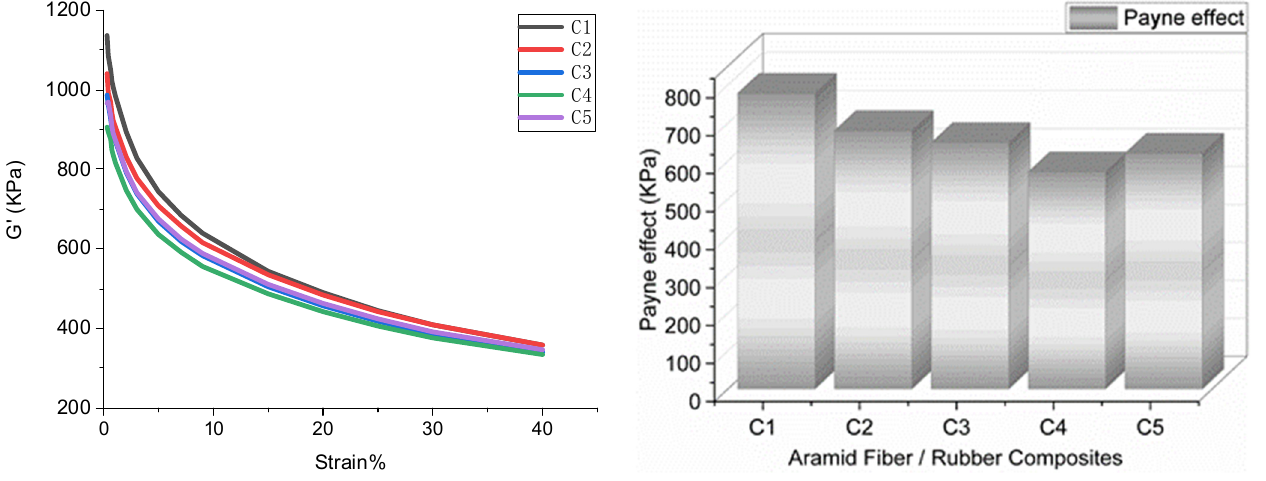
Figure 5. Payne effect.